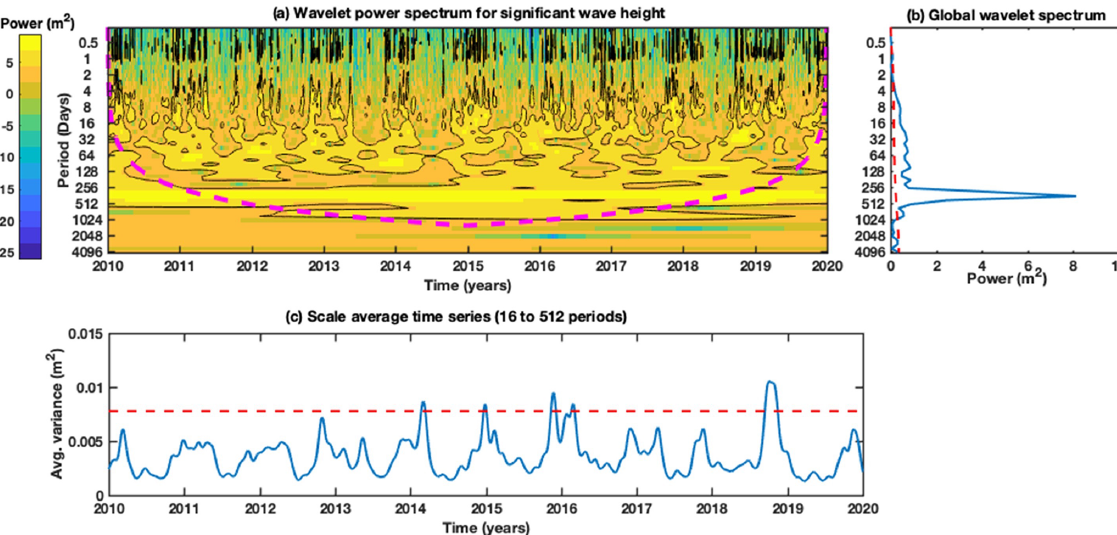
Figure 12. Wavelet analysis of wave climate time series ( H s in m) along the Emilia-Romagna coastal belt at station 6 (Cesenatico; see Fig. 1c for location) using mean model estimates. (a) Wavelet power spectrum for H s . The colour bar stands for the formation of H s variation. Power spectra intensity is represented by colours varying from navy blue colour (i.e. weak) to dark yellow (i.e. strong). The contours represent the total variance percentage, and the black contours indicate amplitude significance (greater than 95% level). The dashed magenta line is the cone of influence (region of spectrum with the significant edge effects), where zero padding has reduced the variance. Figure 11a shows that power is concentrated in the 256–512d band, which is a strong signal. (b) Global wavelet power spectrum, where the blue curve indicates the fast Fourier transform of the complete data. The dashed red line is the significance (95%) for the global wavelet spectrum, assuming the same significance level and background spectrum as in wavelet power spectra. (c) Scaled averaged time series over a 16–512d band showing variance of H s . The dashed red line is the 95% confidence level for H s